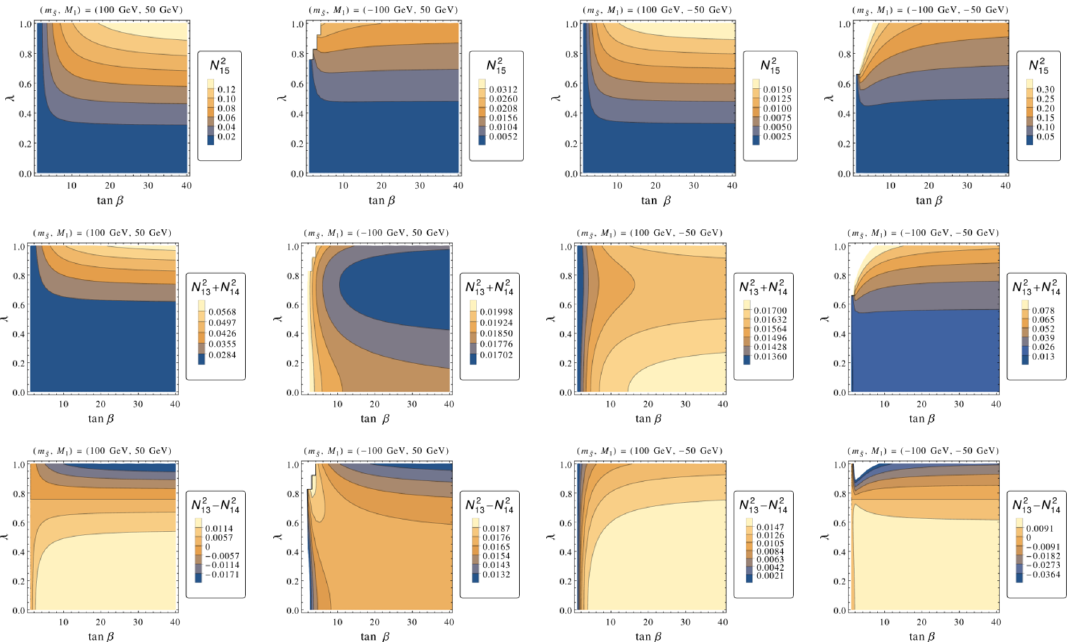
, top panel), the total higgsino ( N 2 + N 2 , middle panel) 15 13 14 (bottom panel) in an LSP (with at least 50% bino-content) − N 2 13 14 (= 350 GeV). In each row the first (last) two plots eff with | M = 50 GeV while | m | = 100 GeV with flipped 1 1 | e S is taken to be 2.5 2